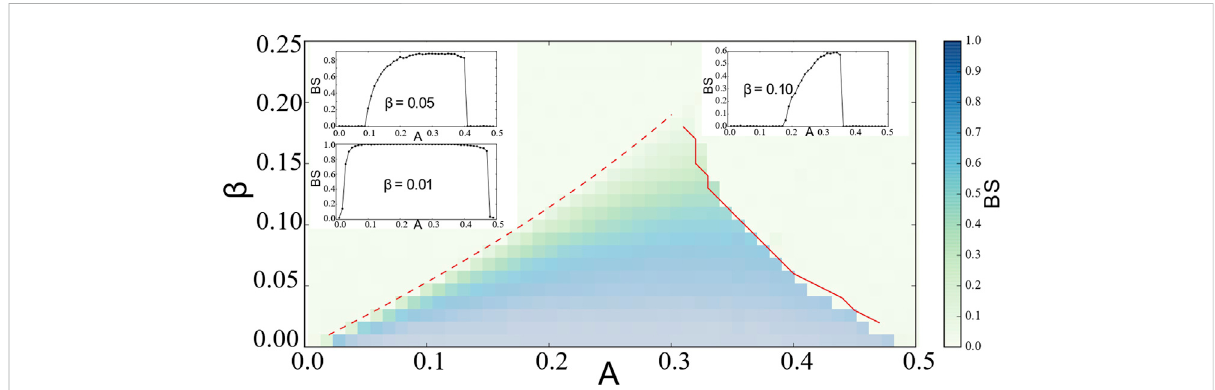
Theprojectionofbasinstability ( BS ) ofchimerastatesofthereducedsystemEq.7onthestabilitydiagram A and β .Ateachpairofparameters( A , β ), BS is calculated independently with 1000 different realizations. Chimera states exist within the region between the saddle-node curve (the red dashed line) and the homoclinic curve (the red solid line). BS fi rst increases with the increase of A and starts decreasing near the homoclinic line as shown intheinsets with differentvalues of β .The saddle-nodecurveis approximated by A SN ( β )in(Abrams etal.,2008).The homoclinic curveis